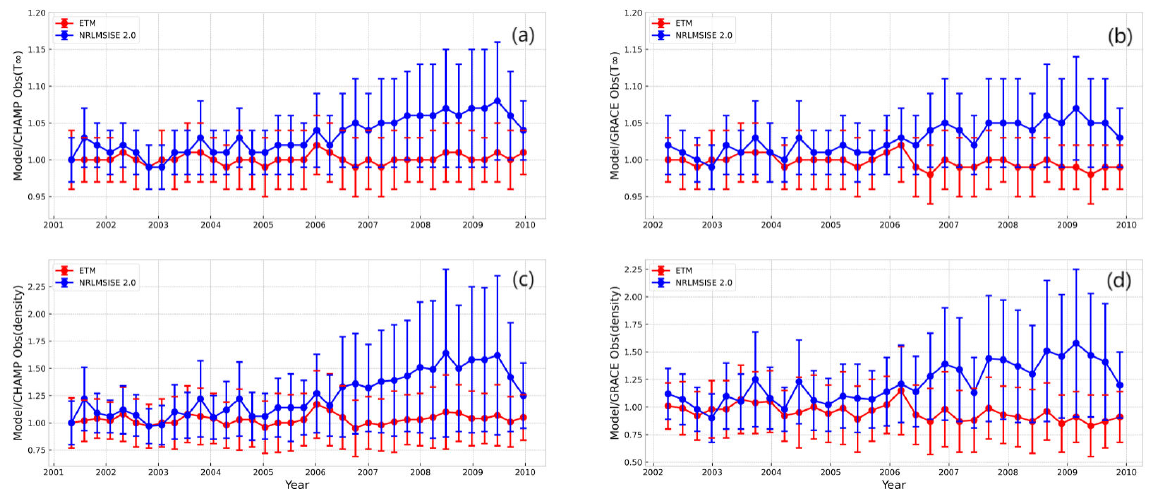
Figure 4. Seasonal ratios and standard deviation between the exospheric temperature from two models and CHAMP ( a ) and GRACE ( b ) results; Seasonal ratios and standard deviation between the density from two models and CHAMP ( c ) and GRACE ( d )